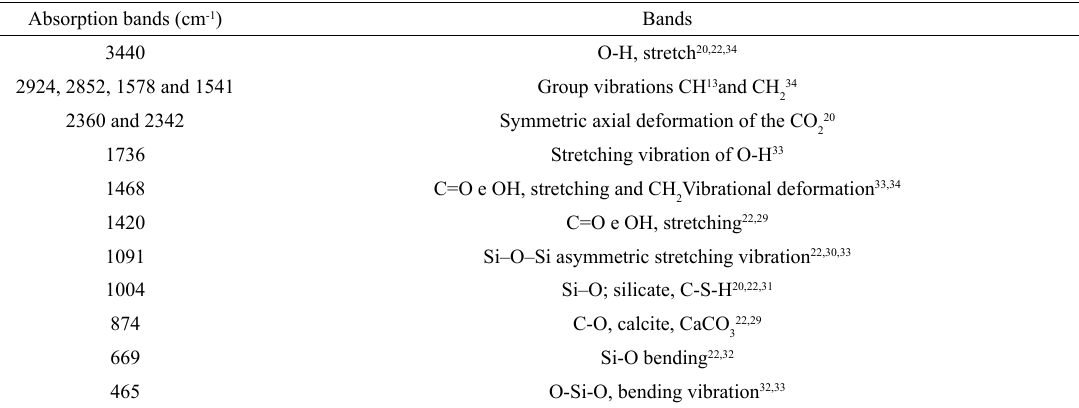
Table 4. Characteristics bands of the T-GCW FTIR samples obtained by FT-IR. Absorption bands (cm -1